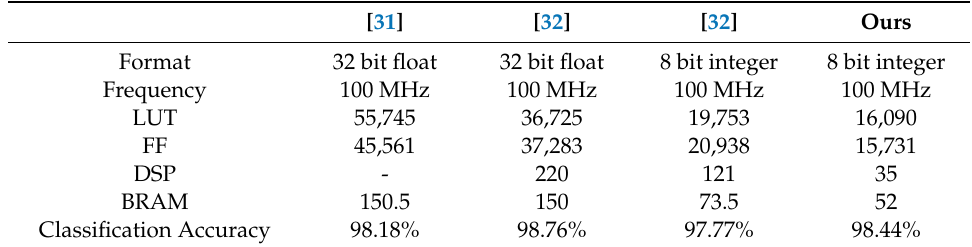
Table 5. Experimental results of our int8 quantization and other previous quantization